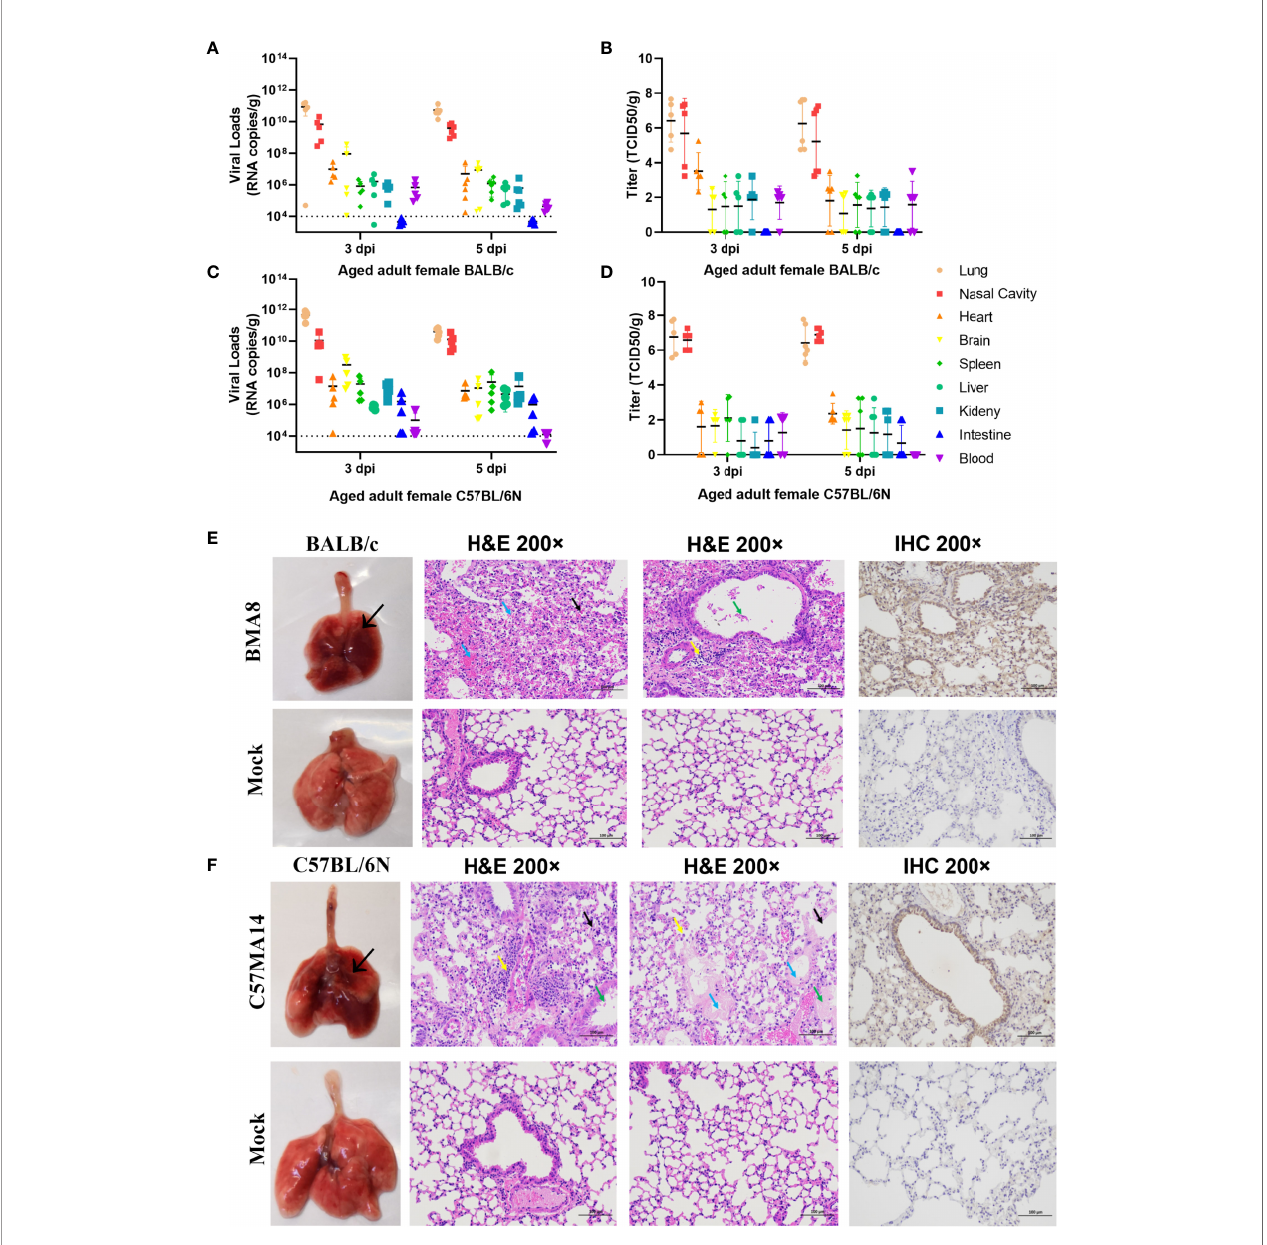
FIGURE 3 | Tissue distribution of the viral RNAs and the pathological lung lesions in passaged mice infected with the mouse-adapted severe acute respiratory syndrome 2 (SARS-CoV-2) BMA8 and C57MA14. To screen virus replication, groups of aged BALB/c mice (n = 10) or aged C57BL/6N mice (n = 10) were infected with 50 LD 50 of SARS-CoV-2 BMA8 or C57MA14, and infected mice were sacri fi ced at 3 dpi and 5 dpi (n = 4 or 5), respectively. The blood and internal organs were harvested to analysis the viral RNA loads by qRT-PCR and TCID 50 (A – D) . Data are presented as mean ± SEM (n = 5). The gross pathology and histopathology of lungs from 9-month-old female BALB/c mice intranasally inoculated with 50 LD 50 of SARS-CoV-2 BMA8 or PBS (Mock) at 3 dpi (E) . The thickened and narrowed alveolar cavity, the congested capillaries in the alveolar wall (black arrow), the in fi ltration of neutrophils (yellow arrow), and perivascular edema and a small amount of in fl ammatory cell in fi ltration (yellow arrow) were observed in lung tissues at 3 dpi after viral infection in BALB/c mice (E) . Lung tissue changes of infected C57BL/6N mice are characterized by exudation in airway (green arrow), thickened alveolar wall (black arrow), alveolar space stenosis, macrophage in fi ltration (yellow arrow), in fl ammatory cell in fi ltration (yellow arrow), and perivascular edema and exudation of protein-like substance in alveolar sac (blue arrow). Similarly, the gross pathology and histopathology of lungs from 9-month-old female C57BL/6N mice intranasally inoculated with 50 LD 50 of SARS-CoV-2 C57MA14 or PBS (Mock) at 3 dpi (F) . Photographs of gross pathological lungs shown in left panels. Local lesions are indicated by arrows. Hematoxylin and eosin stain (H&E) shown in middle panels. Right panels show immunohistochemistry (IHC) labeling against SARS-CoV-2. Scale bar, 100